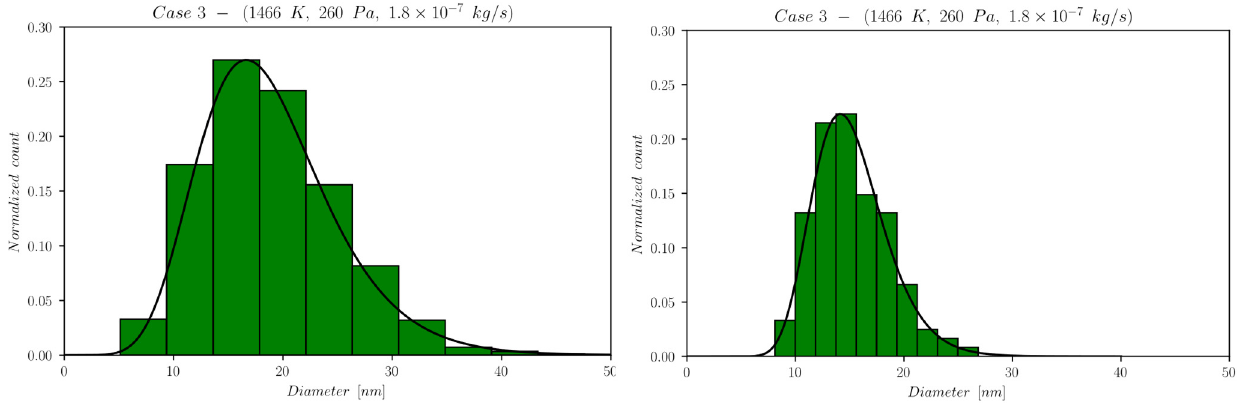
Figure 9. Final PSD for case 3; ( left ) PBM predictions and ( right ) experimental results.